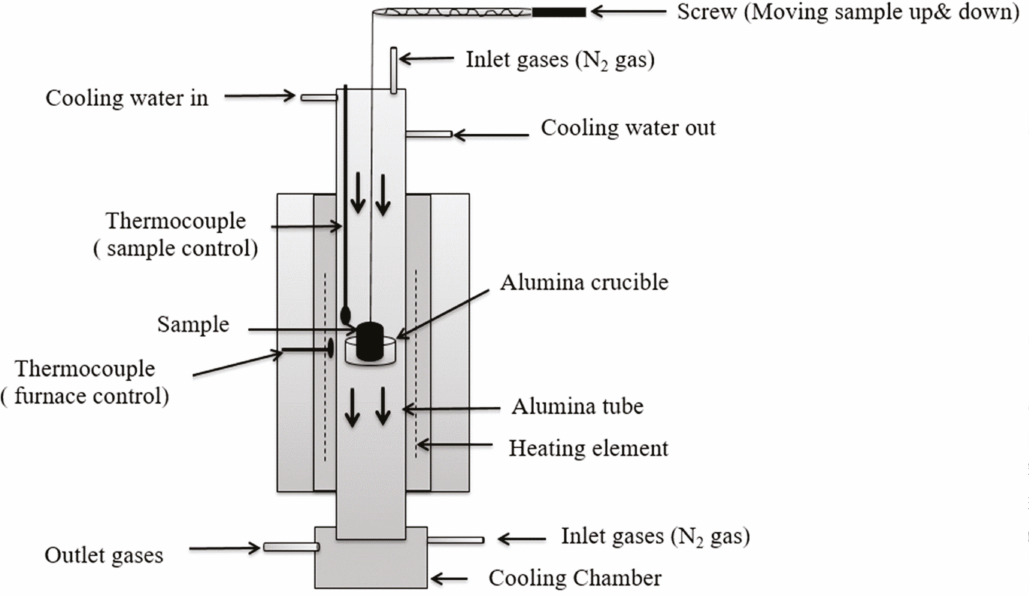
Figure 2. Schematic layout of the tube